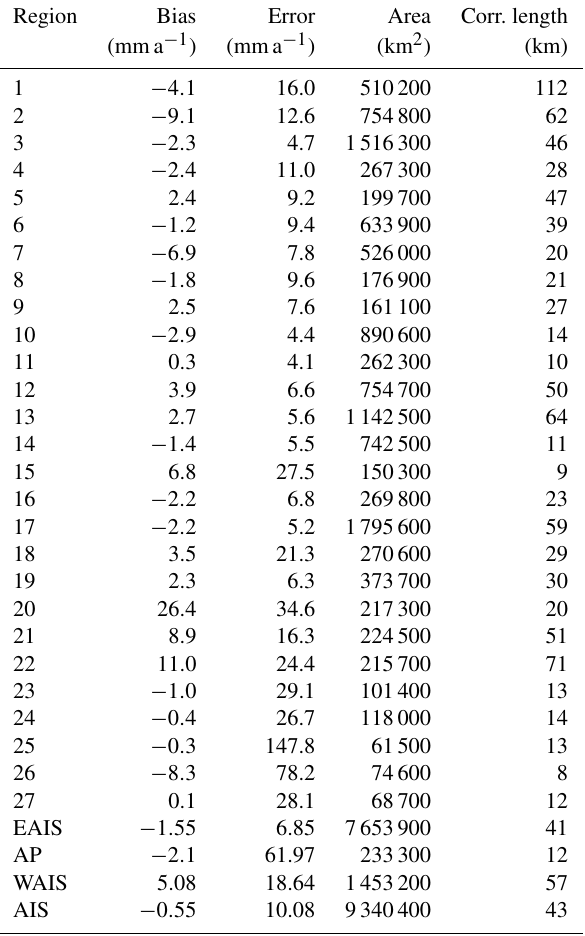
Table 2. Regionally averaged errors for the synthesized JPL record of elevation change, computed relative to the unbiased ICESat to ICESat-2 estimate of Smith et al. (2020). Errors were determined by differencing 2003–2019 linear rates of elevation change between products. The bias (mean: σ s ) and error (standard deviation: σ r ) are computed for each drainage basin (1–27; Fig. 1). Antarctic Ice Sheet (AIS), Antarctic Peninsula (AP), West Antarctic Ice Sheet (WAIS), and East Antarctic Ice Sheet (EAIS) statistics are determined using area weighted